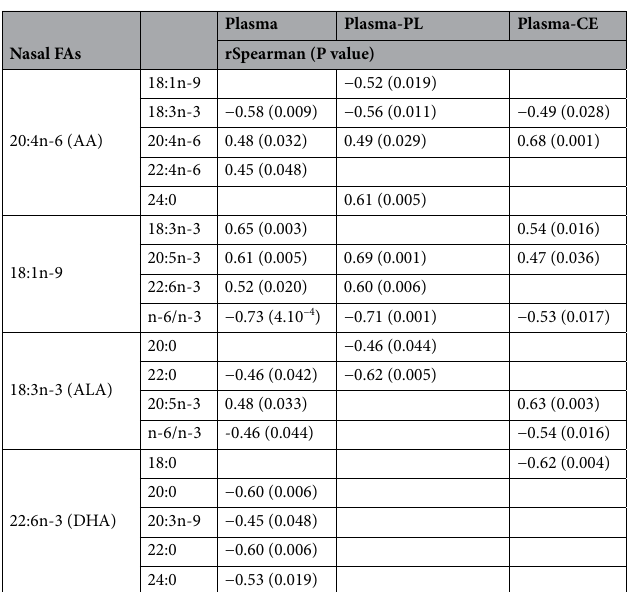
Table 4. Main significant associations between nasal and plasma fatty acid levels (Spearman test; n = 20). AA arachidonic acid, ALA α-linolenic acid, DHA docosahexaenoic acid, CE cholesterol ester, PL phospholipid.